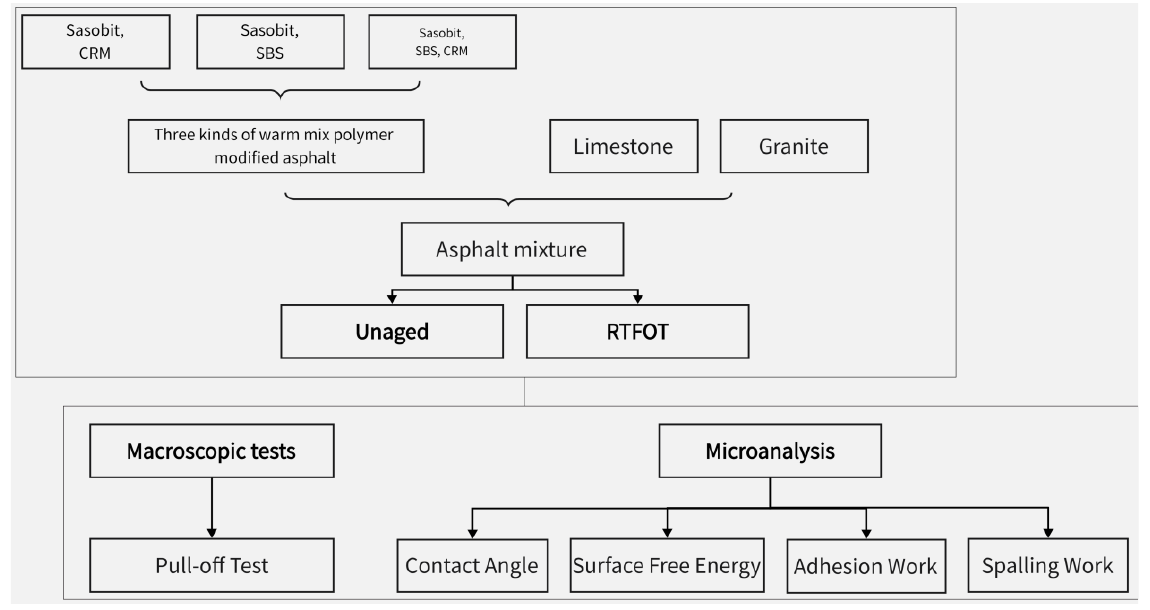
Figure 1. Flowchart of the study.